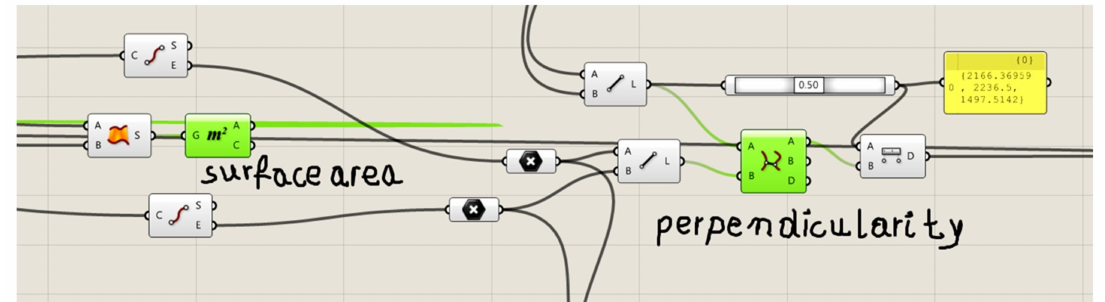
Figure 22. Two basic green components representing two basic conditions related to the fold’s surface areas and line of contraction.